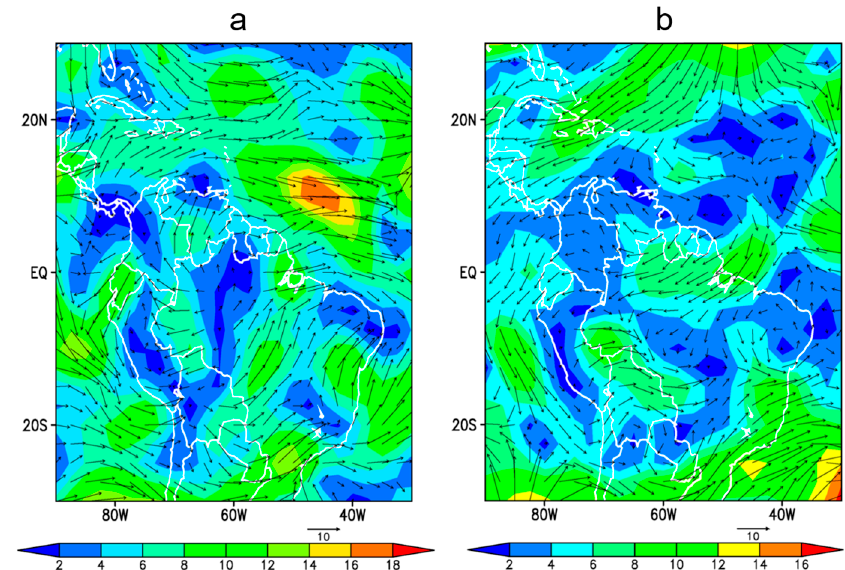
Figure 8. ( a ) Lower troposphere horizontal wind vertical shear estimated from the difference between the horizontal wind at 600 hPa and 850 hPa pressure levels. The shaded areas indicate the wind shear magnitude (m/s). ( b ) Horizontal wind field at the 600 hPa pressure level. The shaded areas indicate the wind magnitude (m/s). The date corresponds to the onset time of the November 1998 SSL. The National Centers for Environmental Prediction (NCEP) Reanalysis data [44] were used to plot the displayed meteorological fields.